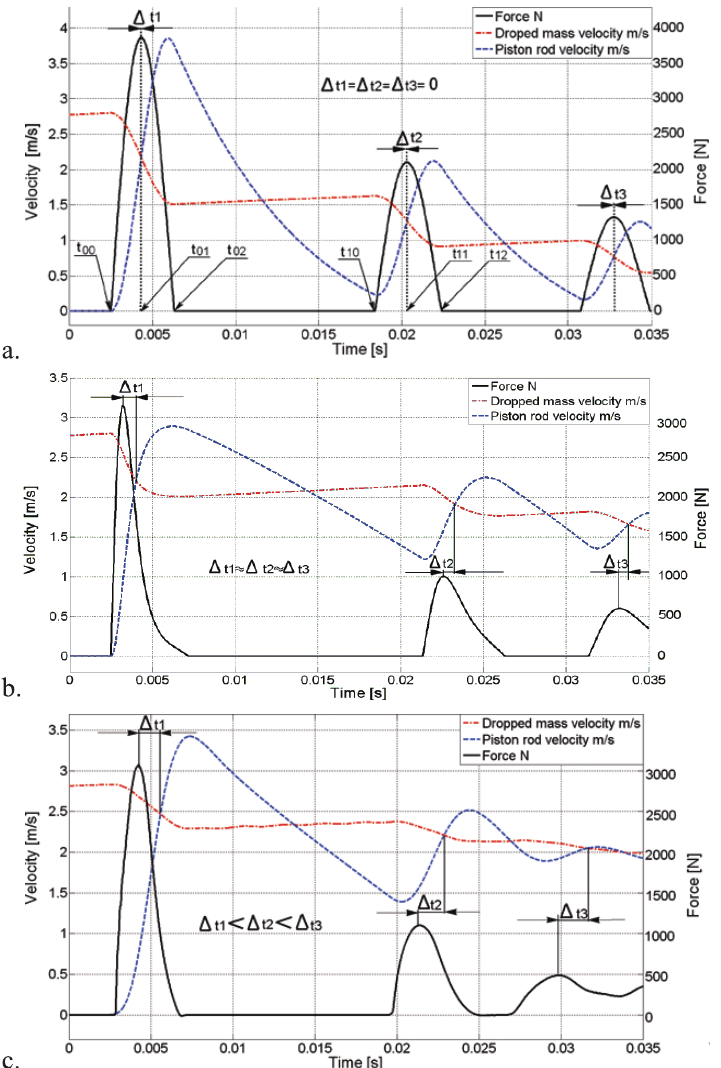
Fig. 9. Contact force and colliding object velocities in time domain for different models of the contact material: a. elastic contact force; b. contact force with nonlinear damping component; c. experimental